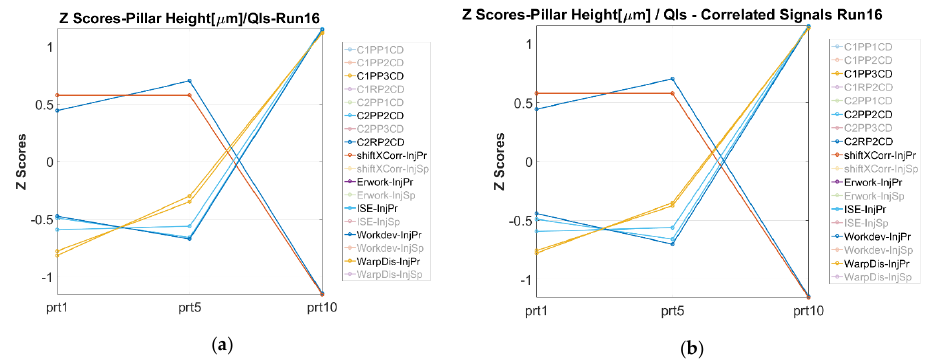
Figure 16. Example of process fingerprint candidates to measurand trends for experimental run 16 based on ( a ) nominal signals and ( b ) cross correlated signals. The legend of the graphs denotes both the measurand datasets (i.e., C1PP1: Cavity 1–Position PP1) and the deviation based (Type 1) “process fingerprints”.